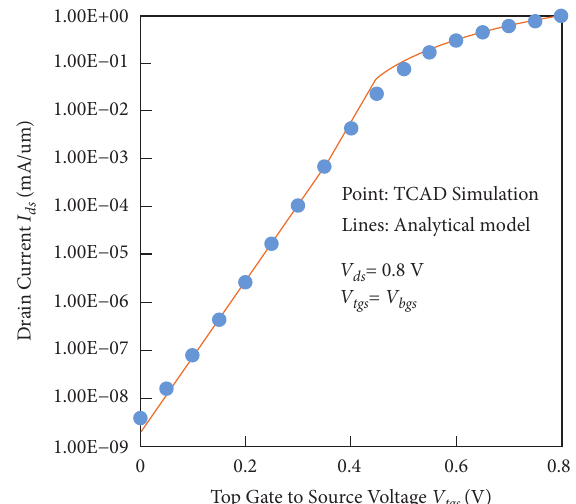
Figure 8: The simulation and calculated results of the current versus V tgs with V ds � 0.8 V and V fgs �